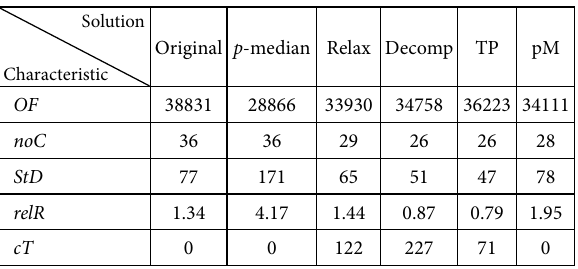
Table 6. Comparison of the results for the region NR